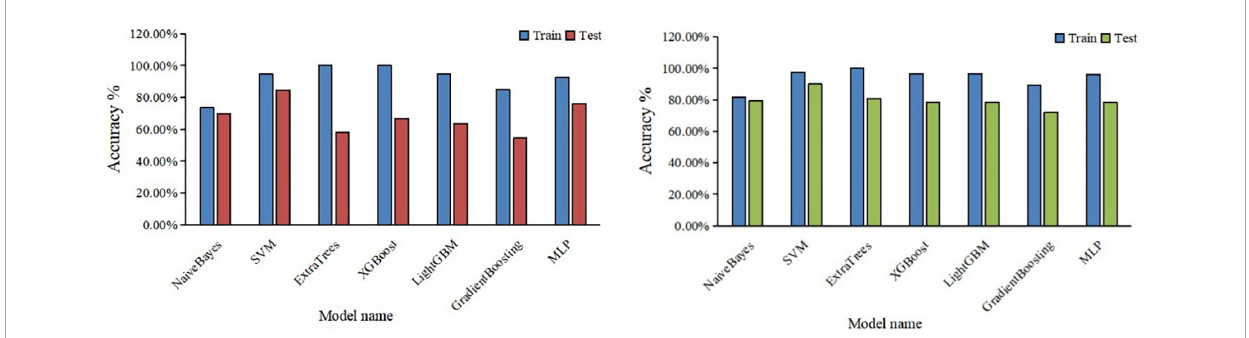
FIGURE5 Boxplots for the range of accuracy of each classification model, the automatic segmentation platform (left) ; the manual segmentation platform (right) .